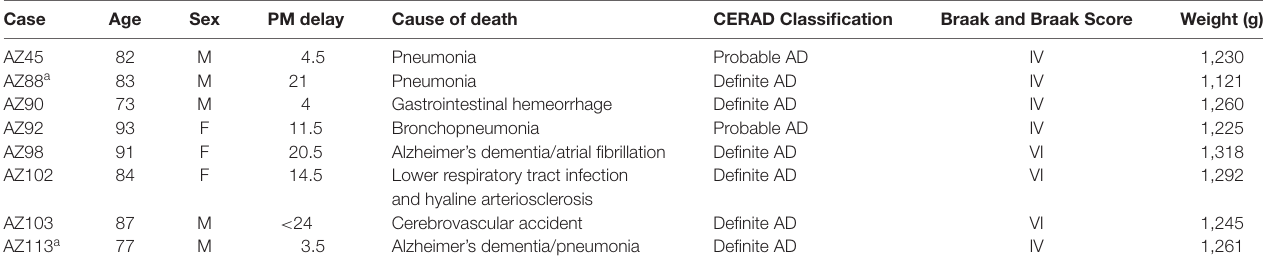
TABLE 2 | Alzheimer’s disease human brain case details used for